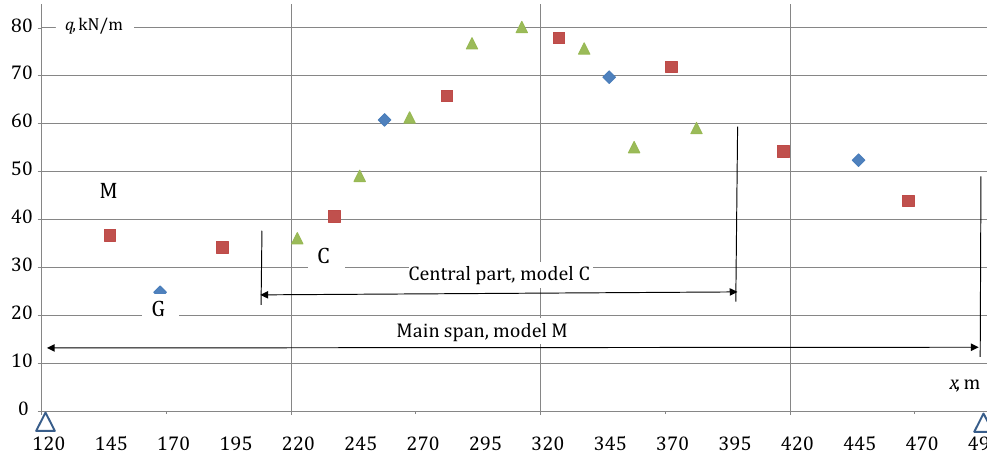
Figure 9. Calculated load intensity for the main